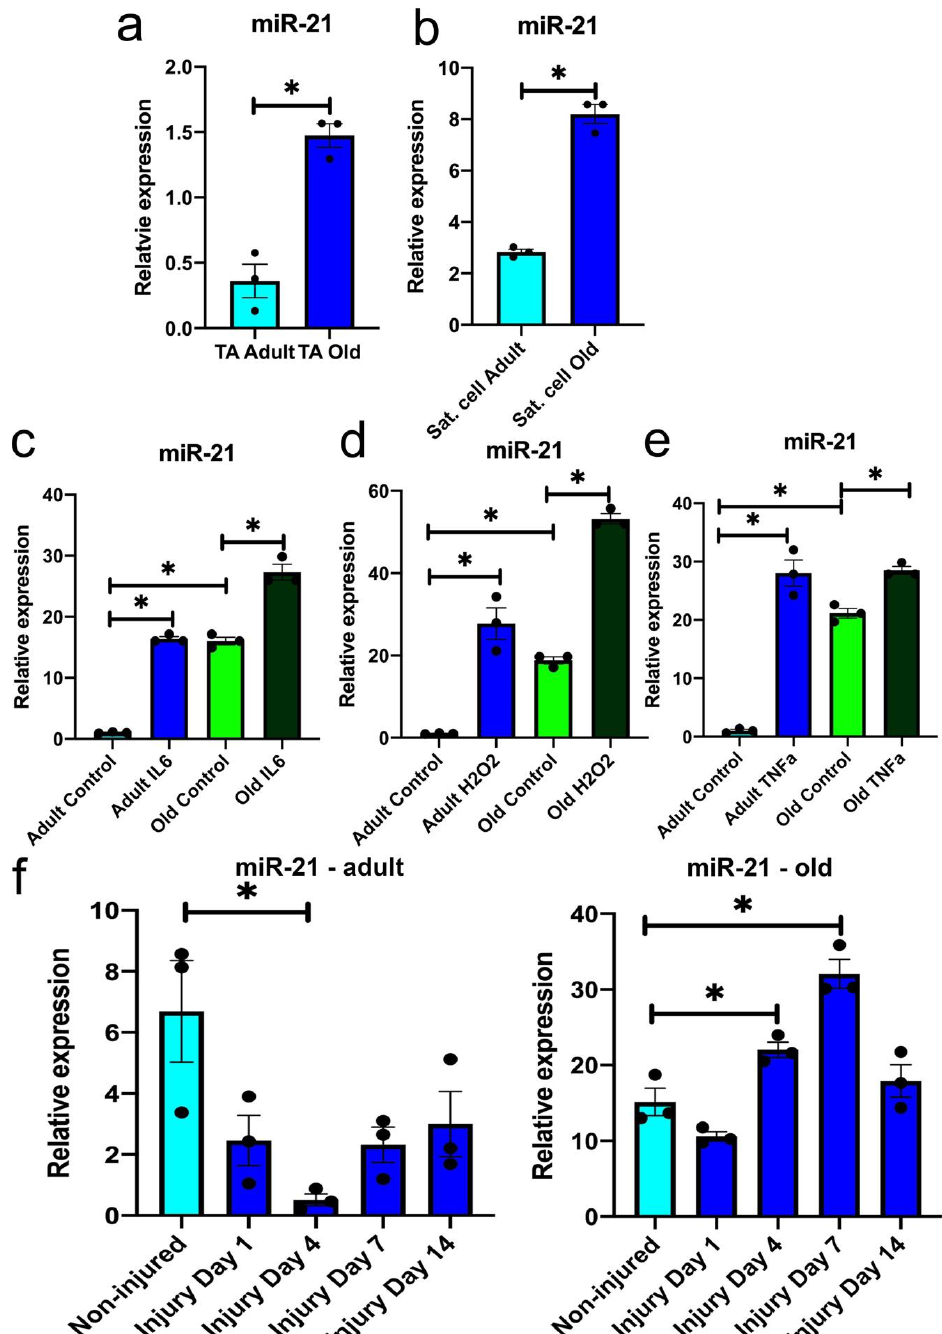
Figure 1. miR-21 expression is regulated in muscle during ageing and regeneration. ( a, b ) qPCR demonstrating changes in miR-21 expression in tibialis anterior (TA) muscle ( a ) and satellite cells ( b ) during ageing. ( c–e ) qPCR demonstrating upregulation in miR-21 expression following the treatment of primary myoblast from adult and old mice with 0.2 ng/mL interleukin 6 (IL6; c ), 50 µM H 2 O 2 ( d ) or 25 ng/mL TNFα, respectively, for 72 h. ( f,g ) qPCR demonstrating changes in miR-21 expression following mouse TA injury with barium chloride in the adult ( f ) and old ( g ) mice; day 0—non-injured muscle; day 1, 7, 14 and 21 days post-injury. • indicates individual replicates. Error bars show SEM, * p < 0.05 (compared to adult or non-injured control, respectively); n = 3 biological replicates. Expression relative to Rnu-6 (miR-21) is